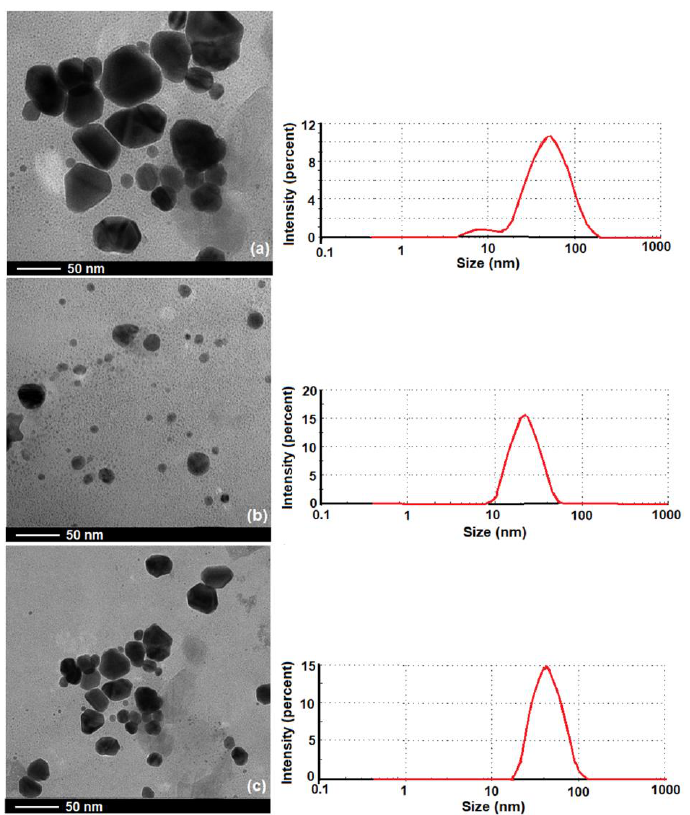
Figure 7. TEM micrographs and DLS particle size distribution graph of the studied materials: ( a ) HPMC-AgNPs, ( b ) PVP-AgNPs, ( c ) 70 HPMC/30 PVP-AgNPs.